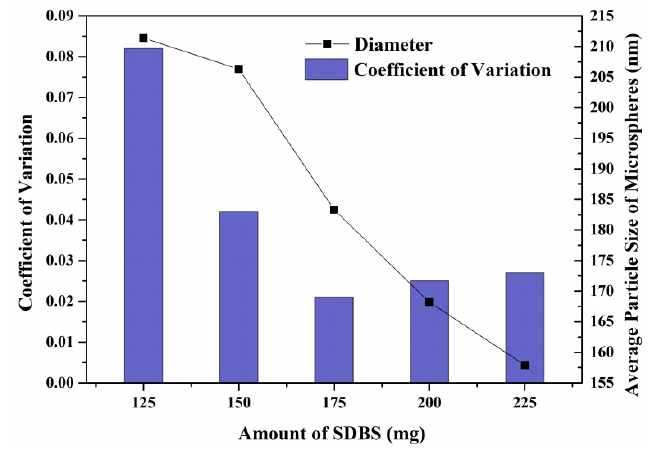
Figure 3. FE-SEM images were manually measured to characterize the average particle size of PSt microspheres synthesized with different amounts of SDBS.